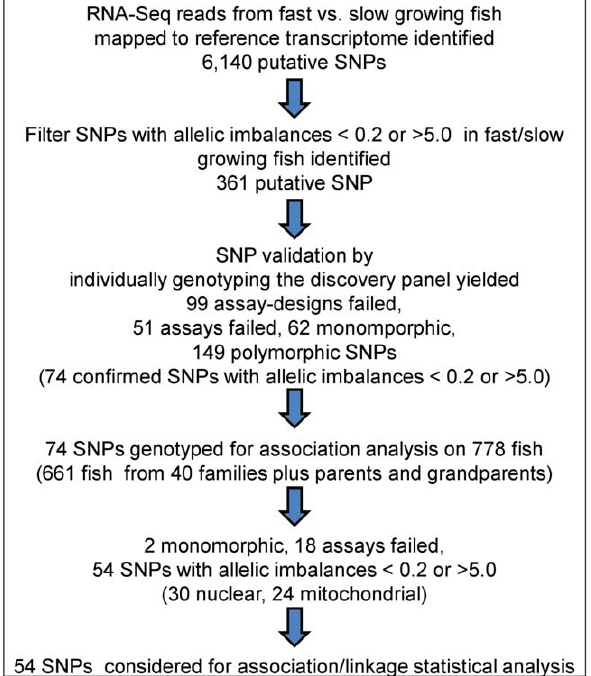
Figure 1. Workflow used for discovery of SNPs associated with growth traits in the rainbow trout transcriptome. SNPs identified in RNA-Seq reads were called and filtered using Alpheus pipeline. The SNP detection stringency conditions include at least 4 reads calling the variant, . 20% reads calling the variant and . 20 Quality score. SNP putatively associated with fast growth were considered at allelic imbalances scores . 5.0 as an amplification and , 0.2 as loss of heterozygosity. SNPs were validated by individually genotyping the discovery panel. Putative SNPs were genotyped for association analysis on 778 fish (40